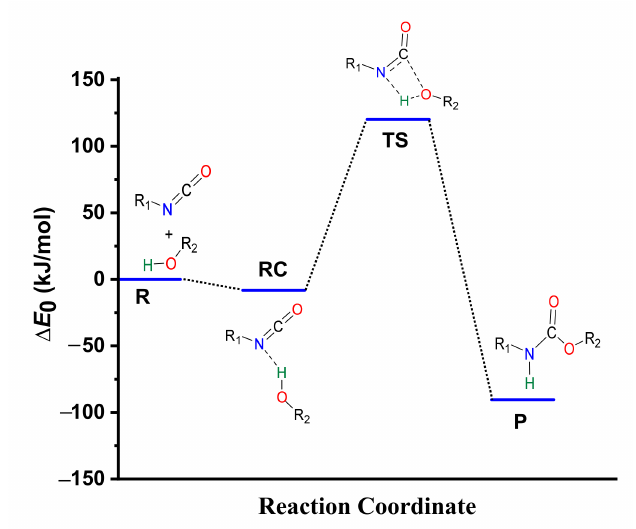
Figure 3. Energy profile (zero-point corrected) of the phenyl isocyanate and methanol reaction calculated using the G3MP2BHandHLYP composite method in acetonitrile, using the SMD implicit solvent model at 298.15 K and 1 atm.